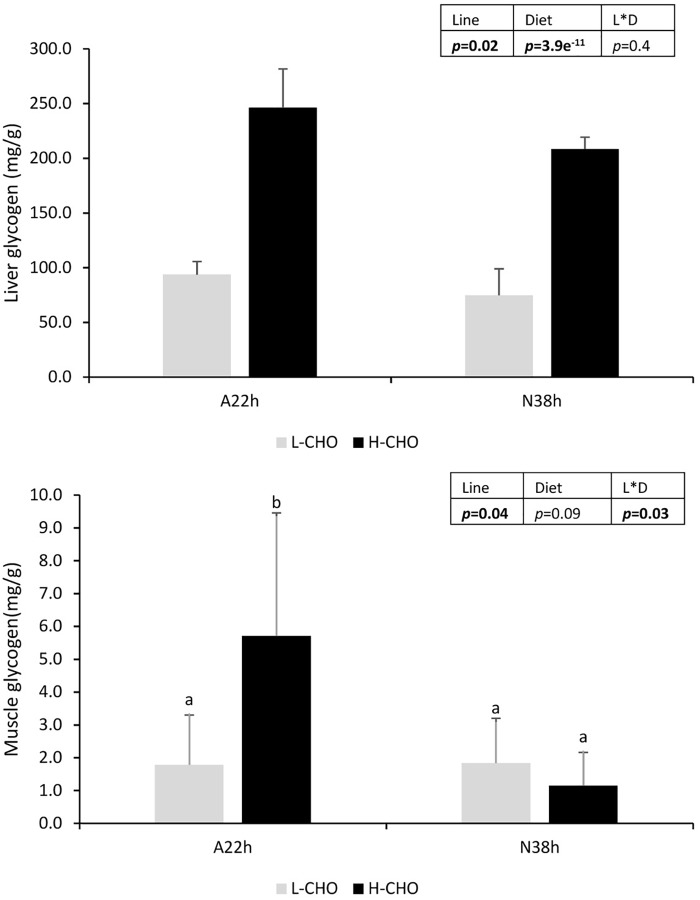
Liver and muscle glycogen in two isogenic lines of rainbow trout (A22h and N38h) fed with low carbohydrate diet (L-CHO) and high carbohydrate diet (H-CHO). Data were presented as mean ± SD (n = 6), statistical differences were evaluated by Two-way ANOVA (p < 0.05, values in bold). In case of interaction, a post hoc Tukey’s test was performed (p < 0.05, values in bold). Different superscripts indicated significant differences between treatments.